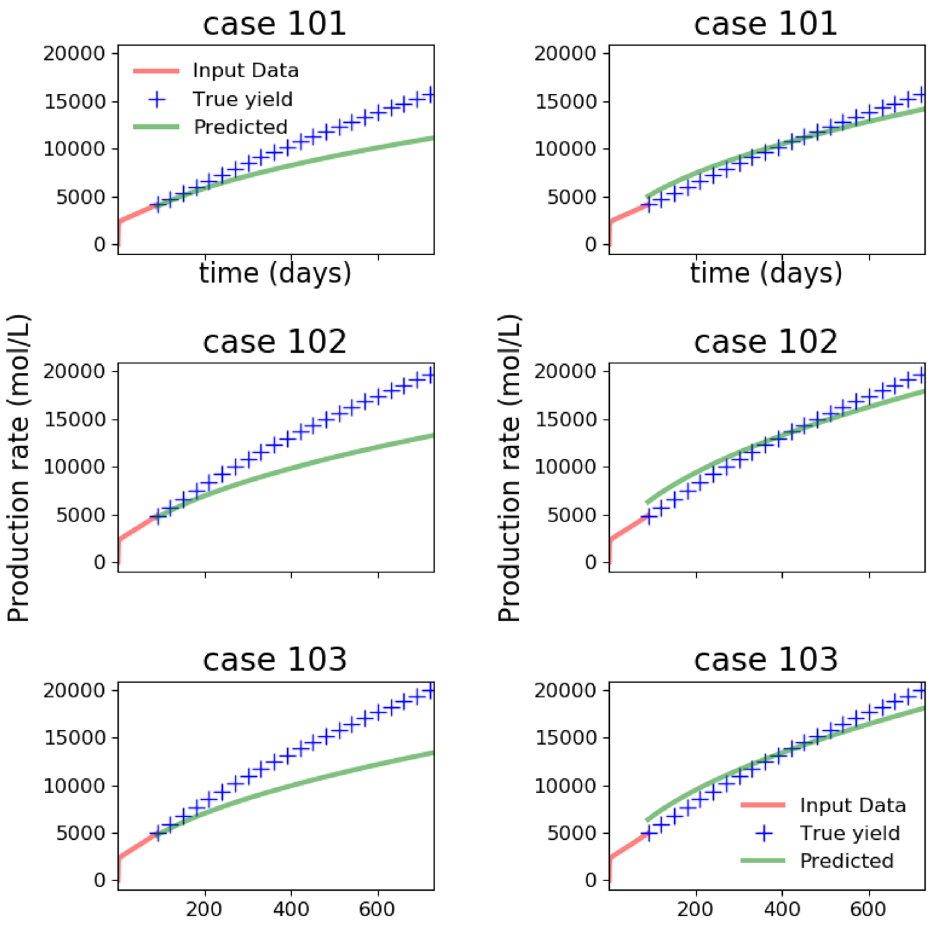
Figure 8. Predicted production profile obtained with Patzek reduced-order model from the ANN with parameter loss function (7) before (left) and after (right) transfer learning. In the previous figure, we observed that before transfer learning, the predicted parameters were reasonable. However, here we see that training with synthetic data from the Patzek reduced-order model is not able to capture the production profile generated by a high-fidelity model, but transfer learning with synthetic data from 100 DFN simulations is able to correct the